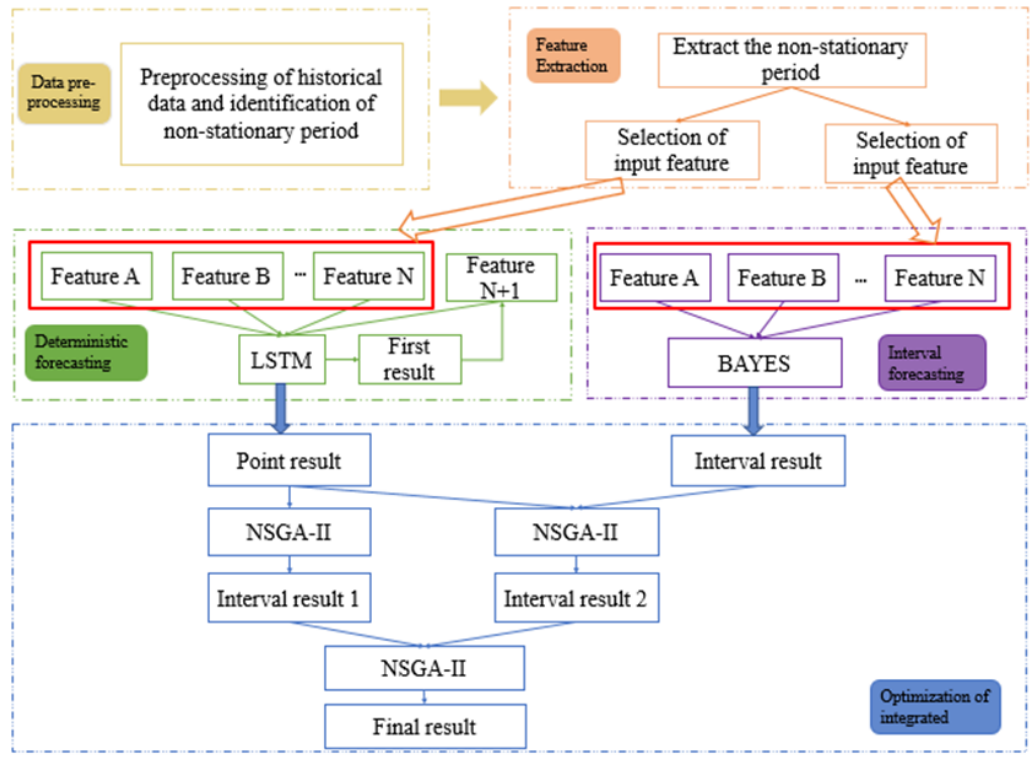
Figure 7. MLBN model framework diagram.